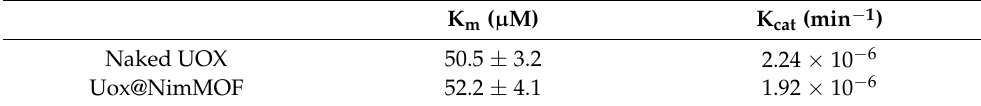
Table 2. Kinetics parameters of both Uox and Uox@NimMOF preparations.